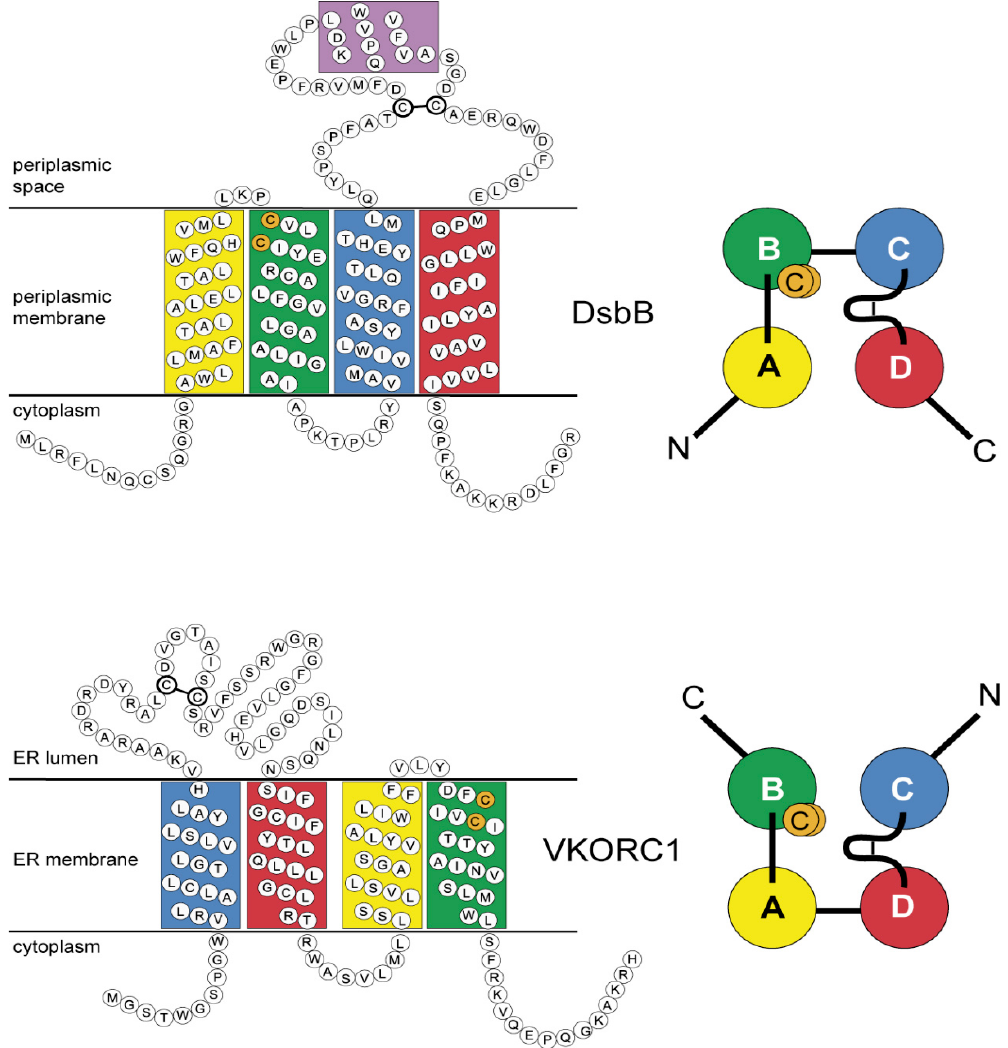
Figure 1. Relationship of structural elements for E. coli DsbB and human VKORC1. Single-letter amino acids (circles); transmembrane helices (four colored rectangles; coloring scheme according to [17]); two active site cysteines (orange circles); DsbB (top left) short helix (purple rectangle); two redox-active cysteines in DsbB large periplasmic loop (thick connected circles); Human VKORC1 (bottom left), transmembrane helix colors for homologous positions relative to DsbB. Transmembrane helical bundle organization and primary sequence threading (N, N-terminus; C, C-terminus) for DsbB (top right, view from periplasm) and VKORC1 (bottom right, view from ER lumen) are shown based on X-ray crystallographic structures. Letters A–D on the right side indicate helix designations used throughout the text. N- to C-terminus direction threading of the primary sequence through DsbB is “ABCD”, but “CDAB” for VKORC1; thus, both threadings are related to each other by circular permutation (CP). Structural elements for DsbB from PDB entry 2HI7 [29], for VKORC1 from PDB entry 3KP9 [14].